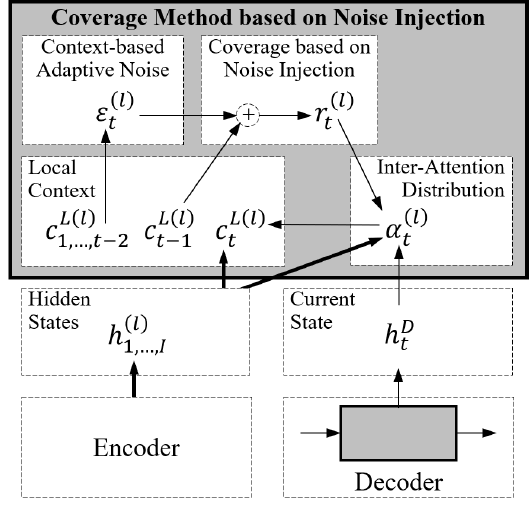
Figure 2. Detailed process of the coverage method based on noise injection.